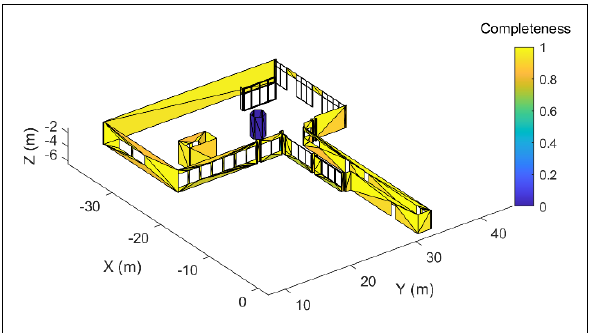
Figure 3. Completeness of individual surfaces of the UVigo model reconstructed by Tran et al. (2019b) shown on the reference model of UVigo.